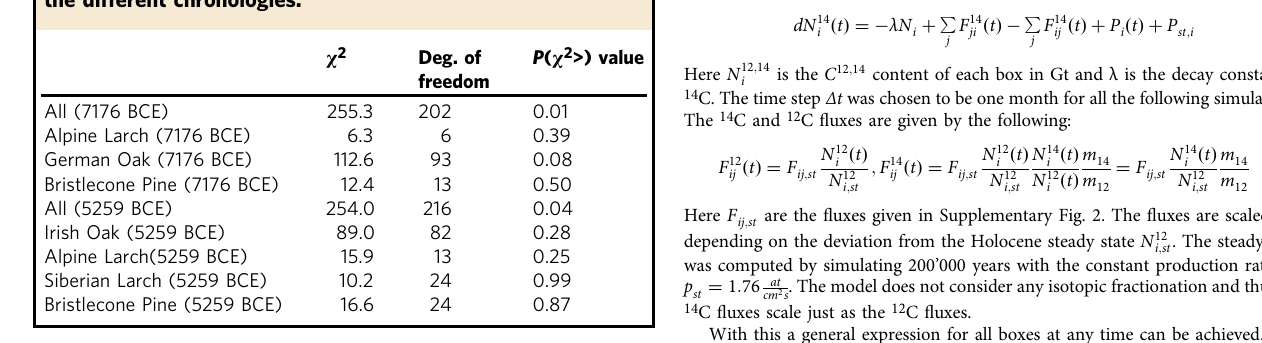
Table 2 Statistical analysis of the repeated measurements of the different chronologies. All (7176 BCE)